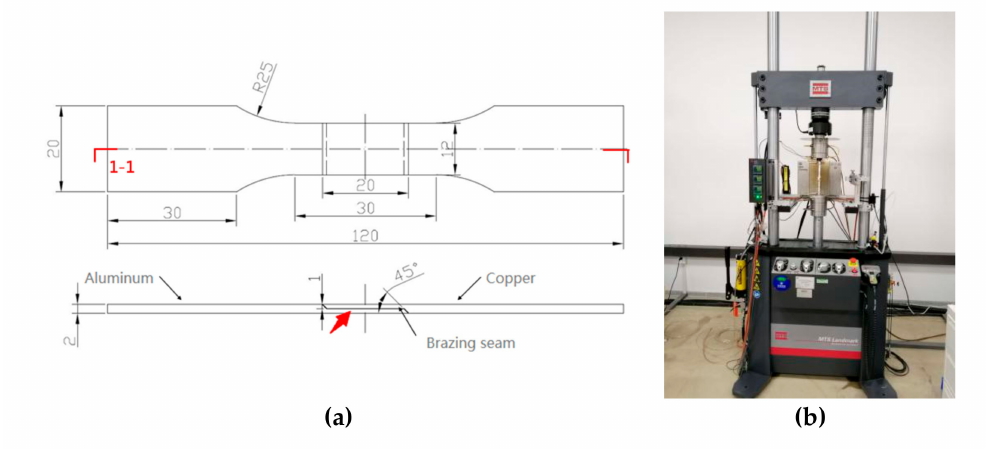
Figure 5. Size of tension test specimen and experiment apparatus. ( a ) Size of tension test specimen. ( b ) Experiment apparatus